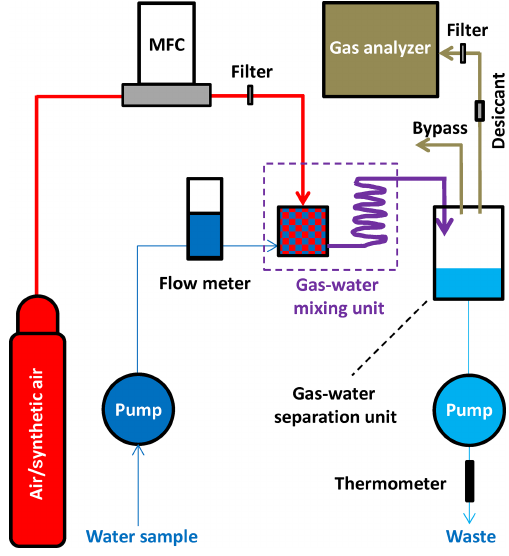
Figure 1. Schematic design of the FaRAGE. The components in- clude an air tank containing compressed carrier gas (air or synthetic air) with a pressure regulator, a mass flow controller (MFC) for generating constant carrier gas flow, two peristaltic pumps for tak- ing and discharging water, respectively, a flow meter for monitoring water sample flow, a gas–water mixing unit, a gas–water separation unit, a gas analyzer, and a thermometer for measuring water tem- perature at phase equilibration. A Teflon membrane filter is placed after the MFC and another is added before the gas analyzer to pro- tect it from being flooded. A desiccant is used to dry the gas flowing to the gas analyzer (if a Picarro isotopic analyzer is used). The red color marks the flow of carrier gas, dark blue line indicates the wa- ter sample, purple line shows the flow of the gas–water mixture, the light brown line shows the flow of the gas sample (after partial equi- libration) and the light blue line depicts the water discharged back to the lake. The thickness of the lines scales with the gas–water flow rates. The arrows show the flow